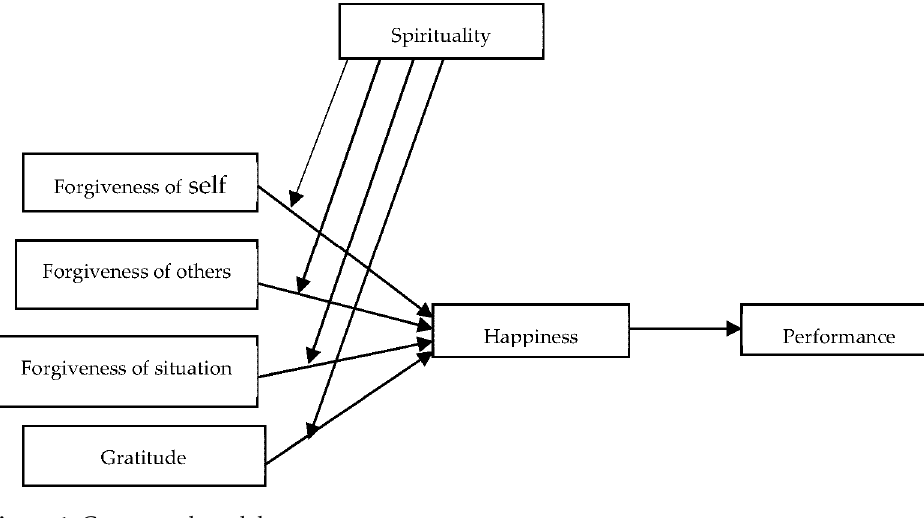
Figure 1. Conceptual